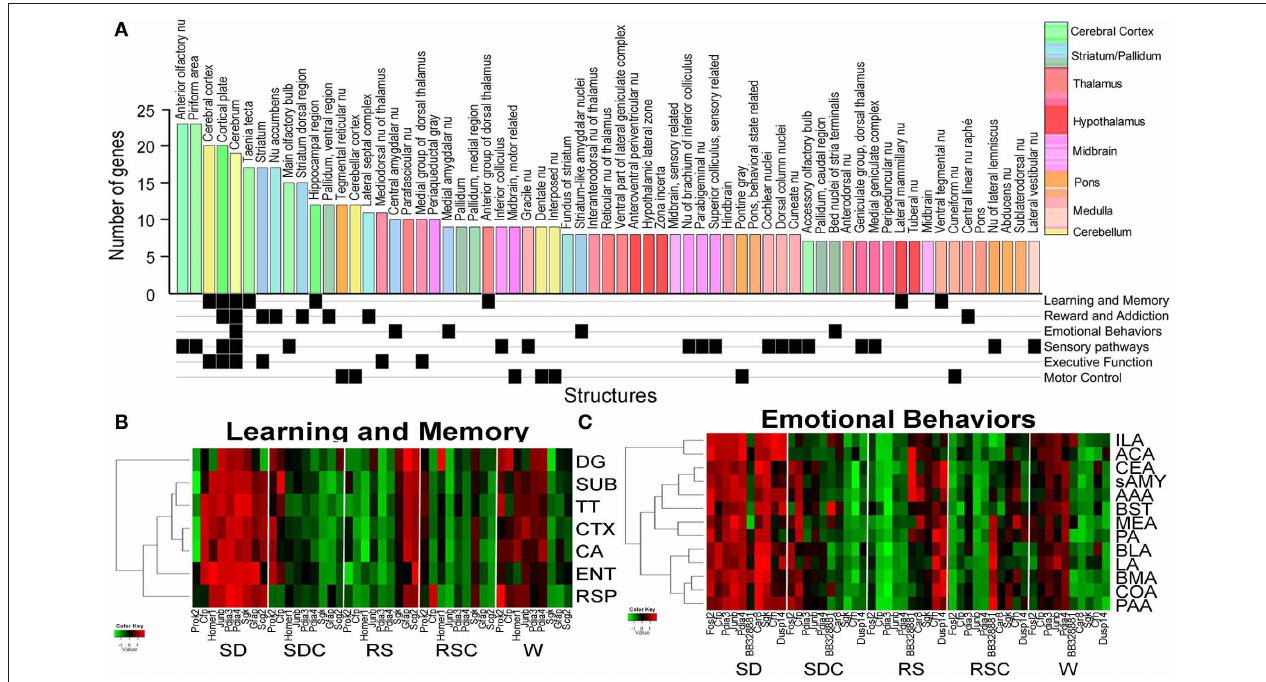
emotional behaviors (C) . Along the x -axis, genes which exhibited differential gene expression across five conditions for any of the given brain regions as determined by triplicate ISH (ANOVA, p < 0.05) are shown. Abbreviations: DG, dentate gyrus; SUB, subiculum; TT, tania tecta; CTX, cerebral cortex;